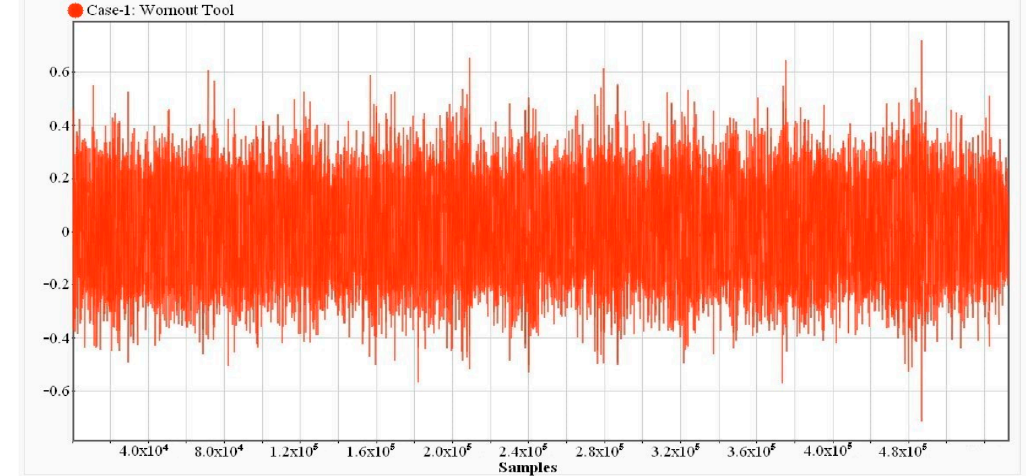
Figure 14. Plot of raw AE signal of 10 s duration for worn-out carbide tool on aluminum work-piece